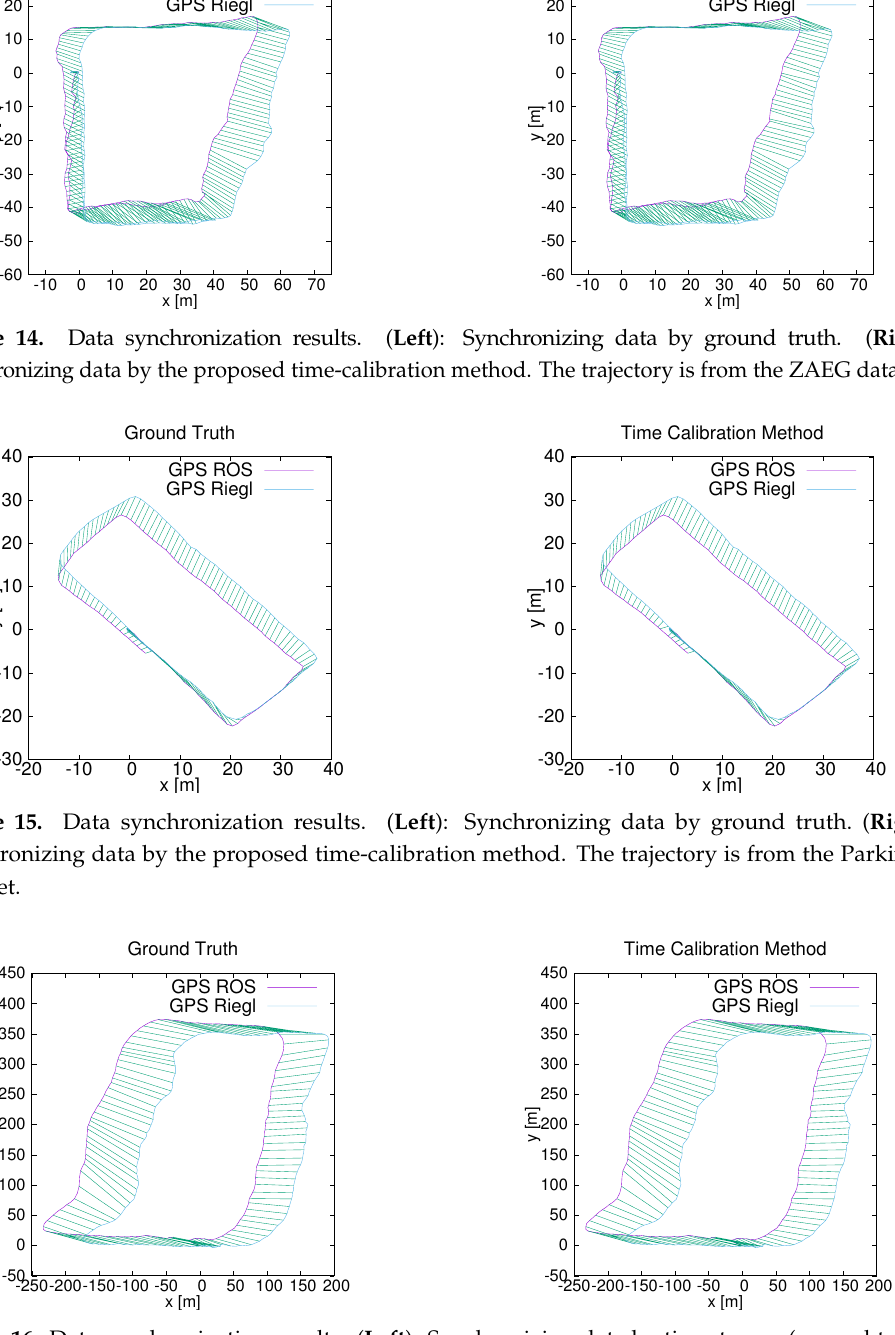
Figure 16. Data synchronization results. ( Left ): Synchronizing data by timestamps (ground truth). ( Right ): Synchronizing data by the proposed time-calibration method. The trajectory is from the Campus data